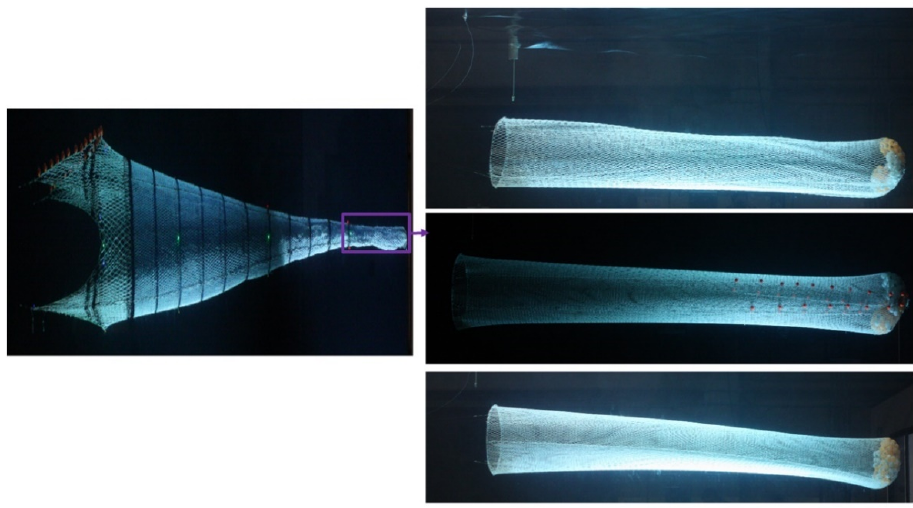
Figure 2. Trawl model ( left side ) and codend models test ( right side ) in the flume tank: ( up ) codend 1, ( middle ) codend 2, and ( bottom ) codend 3. Table 1. Characteristic of trawl net